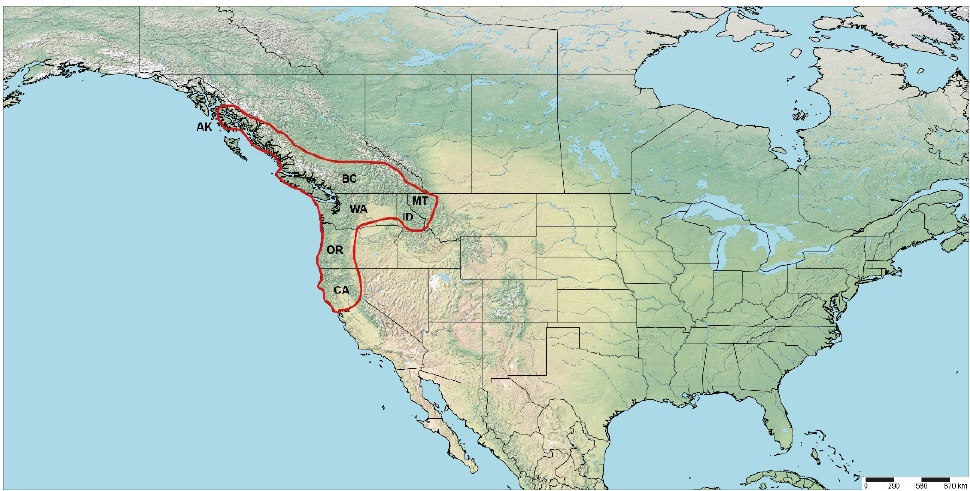
Figure 4. Approximate distribution of Araeopidius monachus (LeConte, 1874). State abbreviations: AK, Alaska; BC, British Columbia; CA, California; ID, Idaho; MT, Montana; OR, Oregon; WA, Washington. Elevational range of adults . Adults have been collected at elevations of 1.2–2013.0 m, with most collections below 1000 m. Collections from the lowest and highest elevations are both from British Columbia (Appendix